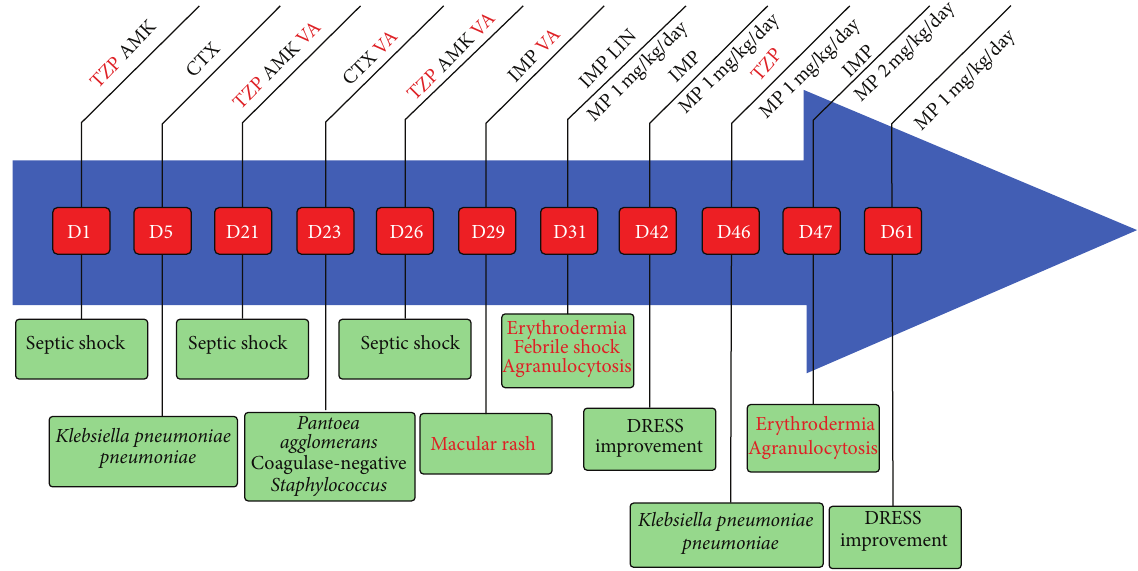
Figure 1: The chronology of events and drugs use related to DRESS occurrences. D: day; TZP: piperacillin-tazobactam; AMK: amikacin; CTX: ceftriaxone; VA: vancomycin; IMP: imipenem; LIN: linezolid; MP: methylprednisolone. Day 1: admission to the ICU.